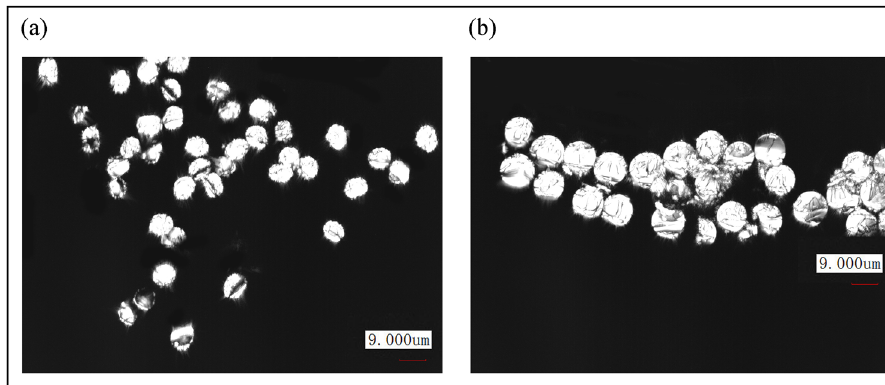
Figure 12: Synthetic laser image of yarn ’ s cross section. ( a ) CF yarn and ( b ) basalt yarn.